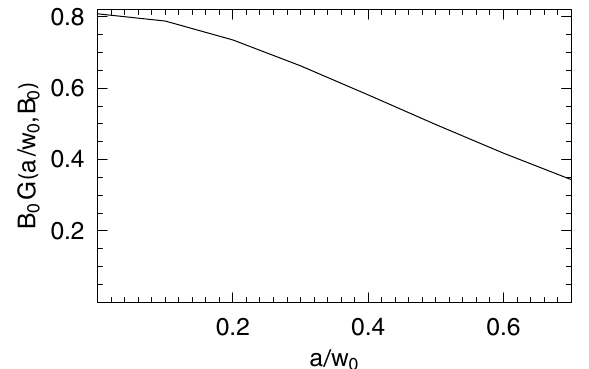
(cid:8) in Eq. (40) evaluated at the G (cid:7) A; B 0 0